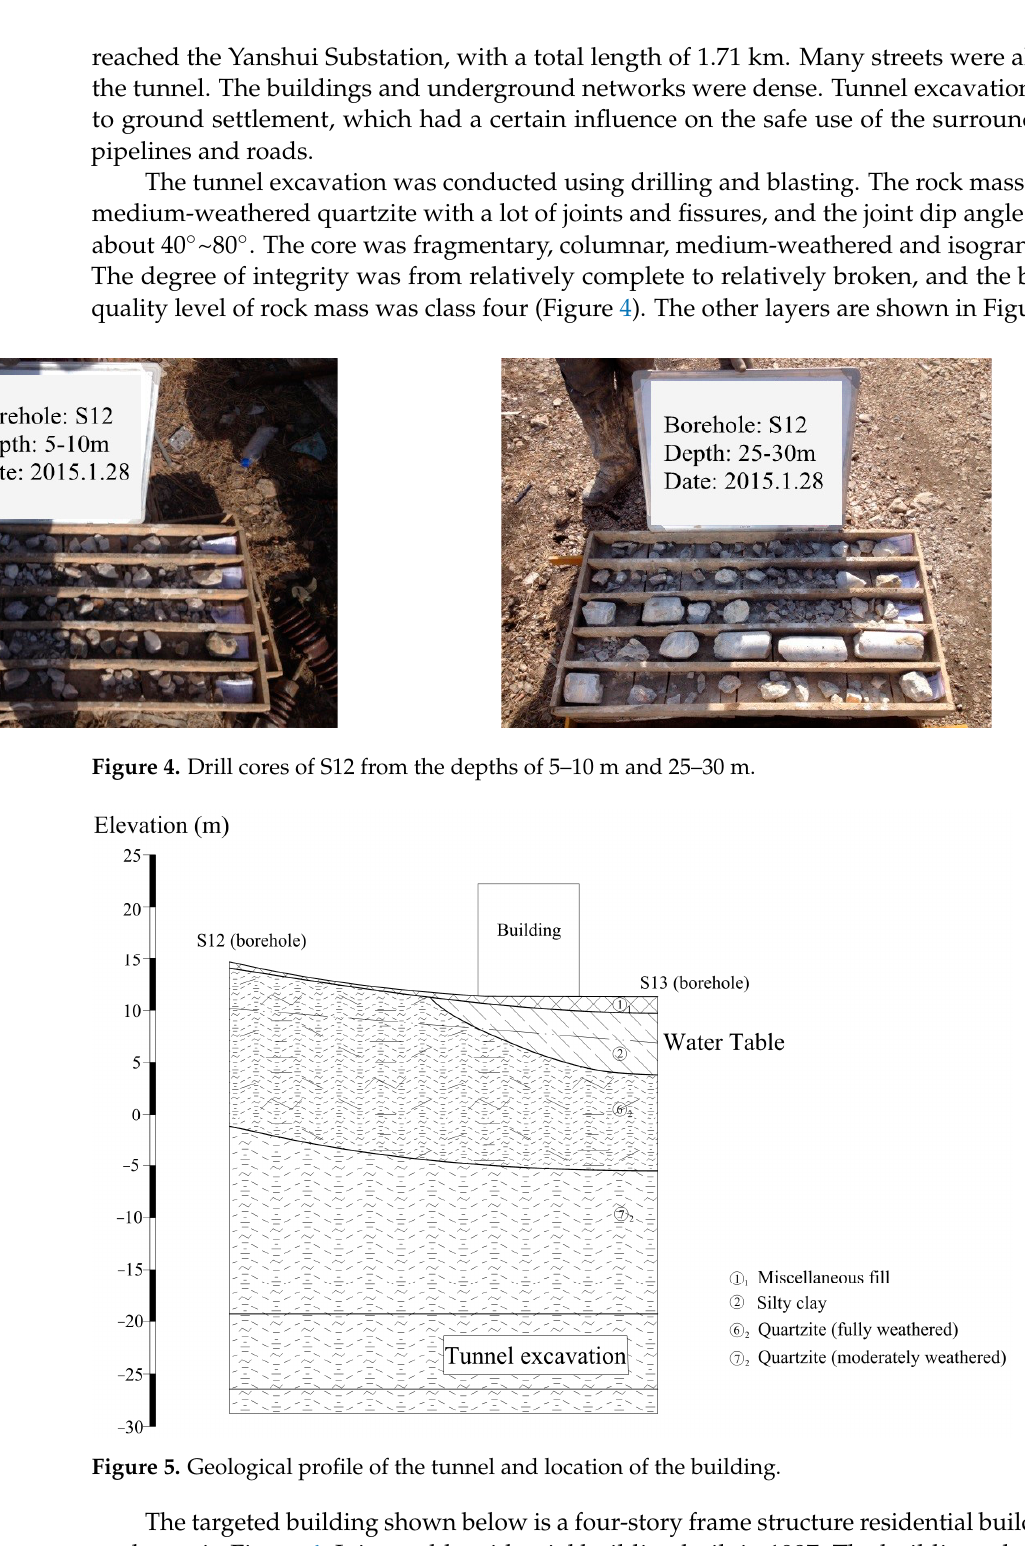
Figure 6. Dimensions of the target building . 4. Data Analysis